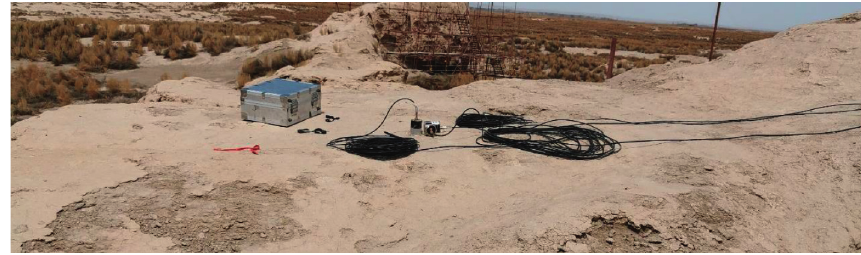
Figure 3: Measurement point